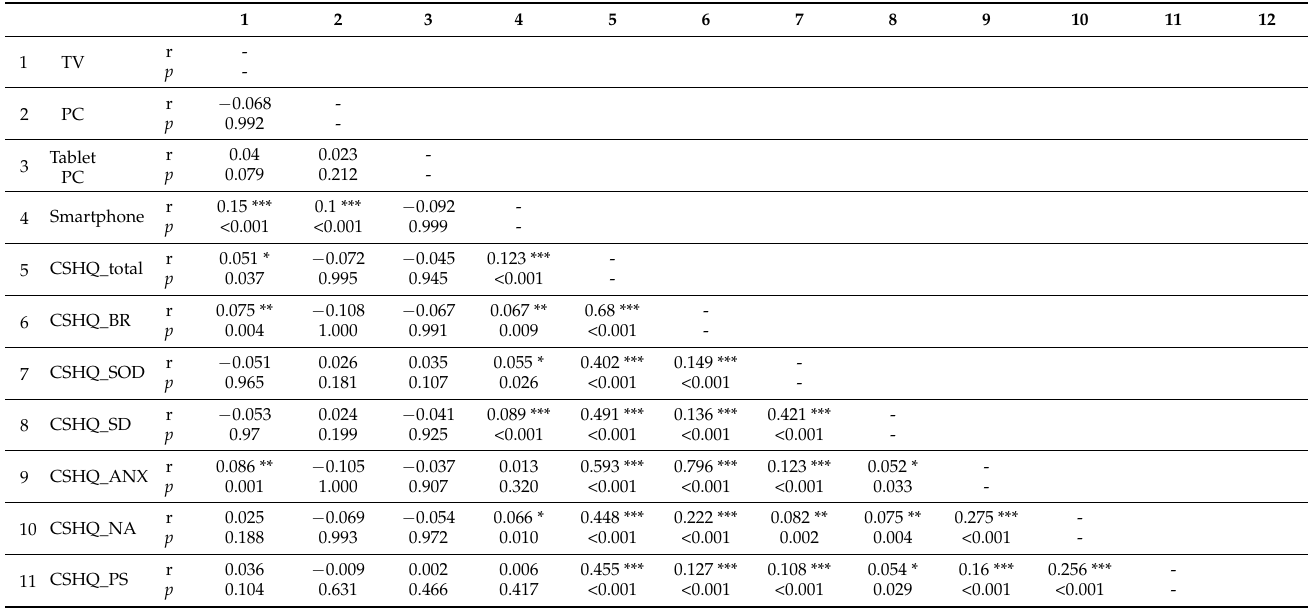
Table 5. Correlation between variables and CSHQ subscale